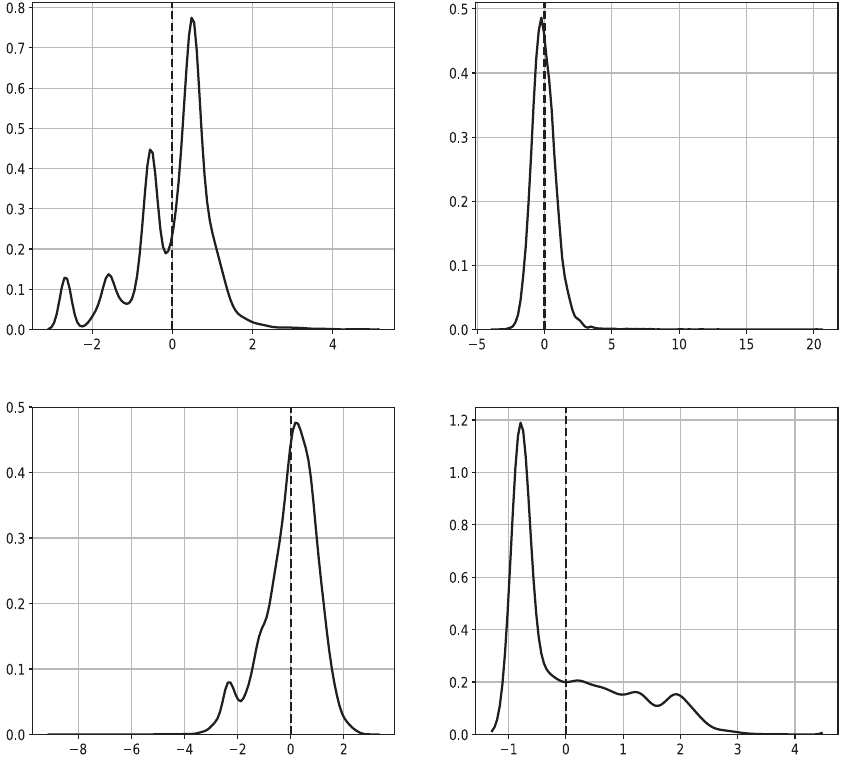
Figure 4. Examples of distribution of variables from real EAF production. All variables are normalized. Top left: Propane. Top right: Refining time. Bottom left: Total weight. Bottom right: Material Type